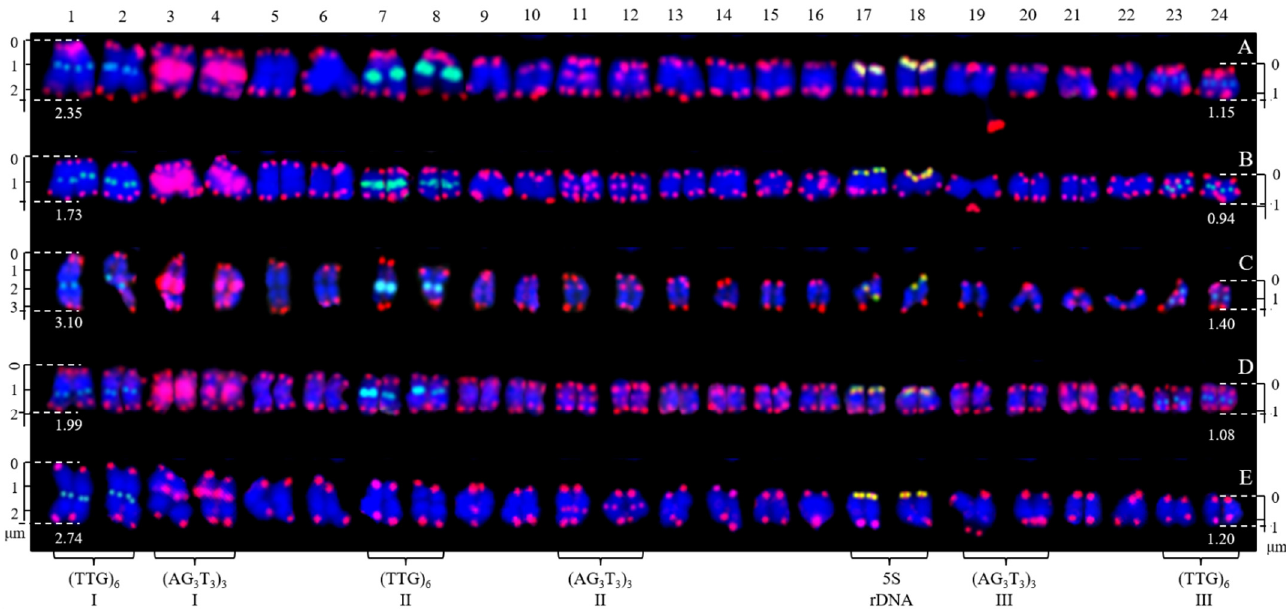
Figure 3A (yellow dotted line), 4 chromosomes in Figure 3B (red dotted line), and 2 chromosomes in Figure 3D (red dotted line). The blue chromosomes were counterstained by DAPI. Scale bar = 3 μ m.